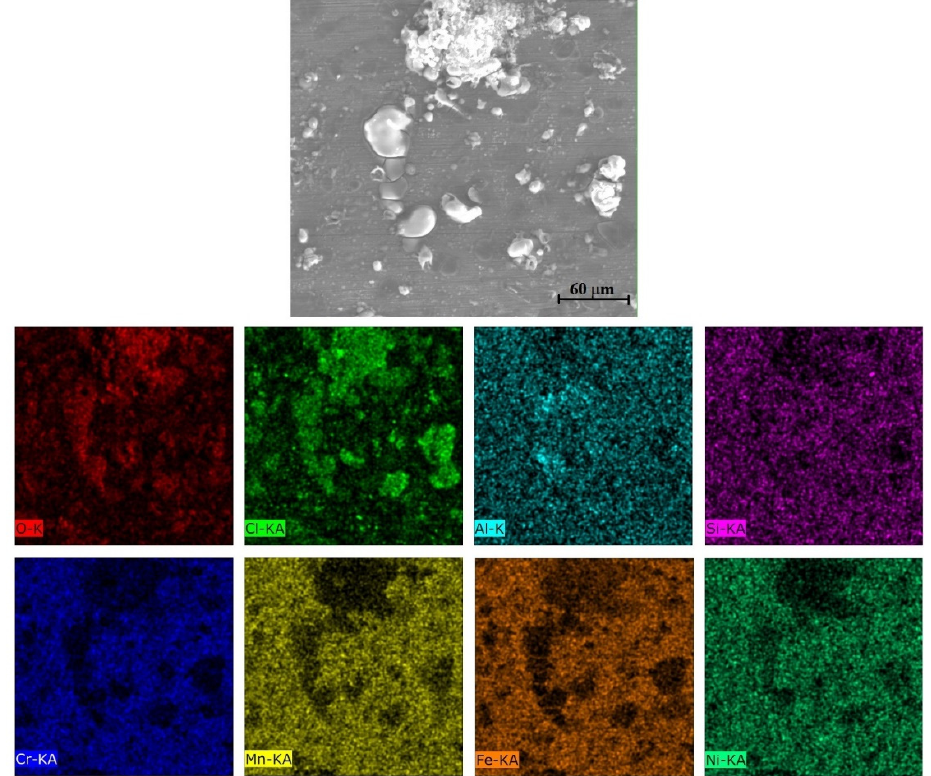
Figure 14. EDX elemental mapping of the corroded cold-rolled Fe 36 Mn 20 Ni 20 Cr 16 Al 5 Si 3 HEA in 0.6 M NaCl with 0.5 M H 2 SO 4 .